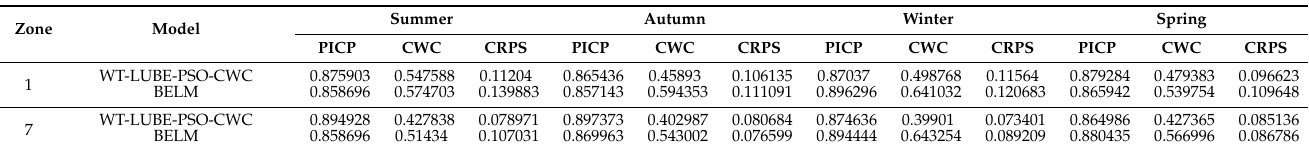
Table 11. Results of the evaluation of WT-LUBE-PSO-CWC and BELM models in zone 1 and zone 7 for summer 2012 to spring 2013 at the 0.85 confidence level.